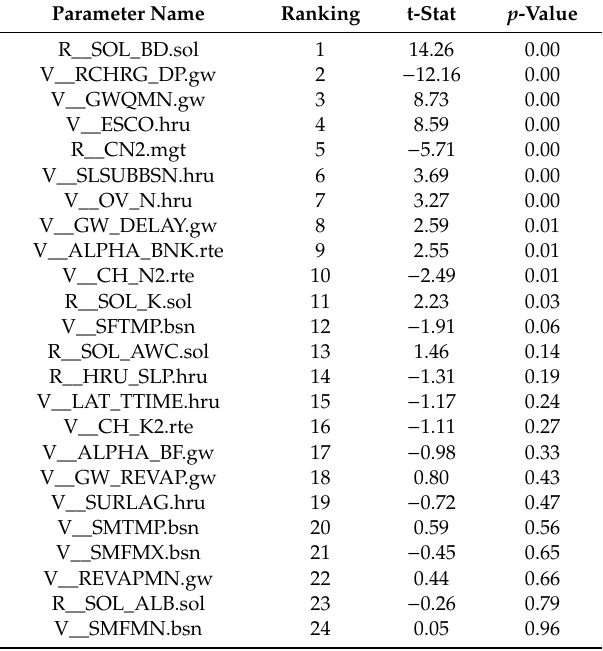
Table 2. T-stat and p -value of Soil and Water Assessment Tool (SWAT) model parameters by sensitivity analysis.